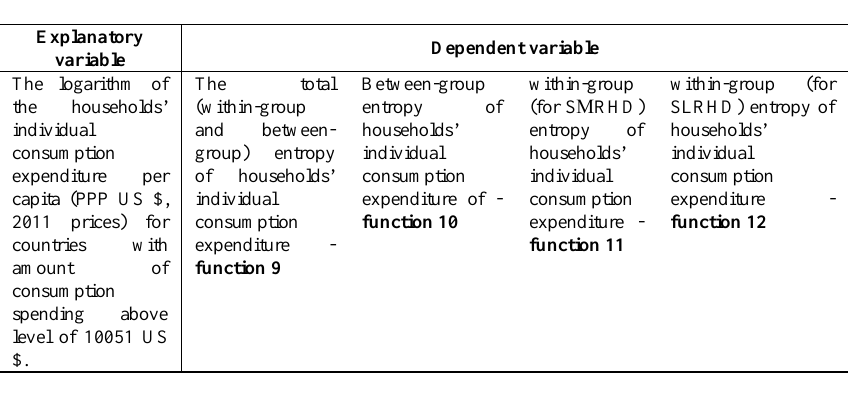
Table 5. Variables specifications